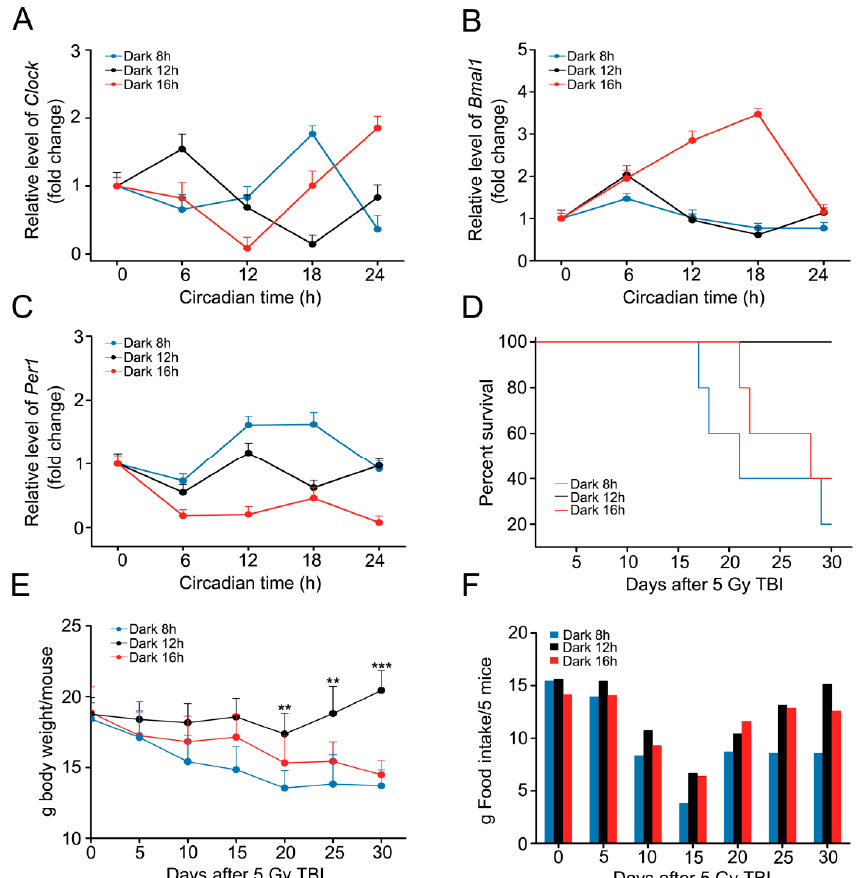
Figure 2. Circadian rhythm disorder impairs the radioresistance of mice. ( A – C ) The expression level of Clock ( A ), Bmal1 ( B ), and Per1 ( C ) was examined by qRT-PCR using the peripheral blood of mice from different cohorts after irradiation; ( D ) Kaplan-Meier survival analyses of mice from the three cohorts, after irradiation, were performed. p < 0.05 using a log-rank test between the 12 h dark/12 h light group and the 8 h dark/16 h light (or 16 h dark/8 h light) group, n = 10 per group; ( E ) The body weight of mice from the three groups, after irradiation, were measured every 5 days, n = 10 per group; ( F ) The food intake of five mice was assessed every five days. Statistically significant differences are indicated: *** p < 0.005; ** p < 0.01; Student’s t -test. TBI, total body irradiation.